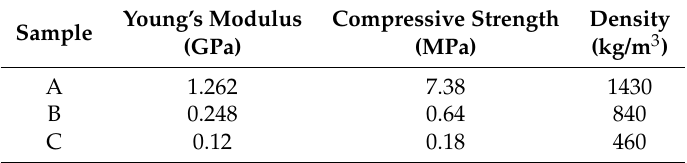
Figure 5. ( Left ): Experimentally measured response of the samples A, B, and C under uniaxial compression. ( Middle ): Experimentally measured response of composites B and C under confined compression. ( Right ): Sample C at the final state of compaction. Table 3. Material properties of grout samples A, B, and C. Young’s modulus and compressive strength are obtained from the uniaxial compression tests (Figure 5